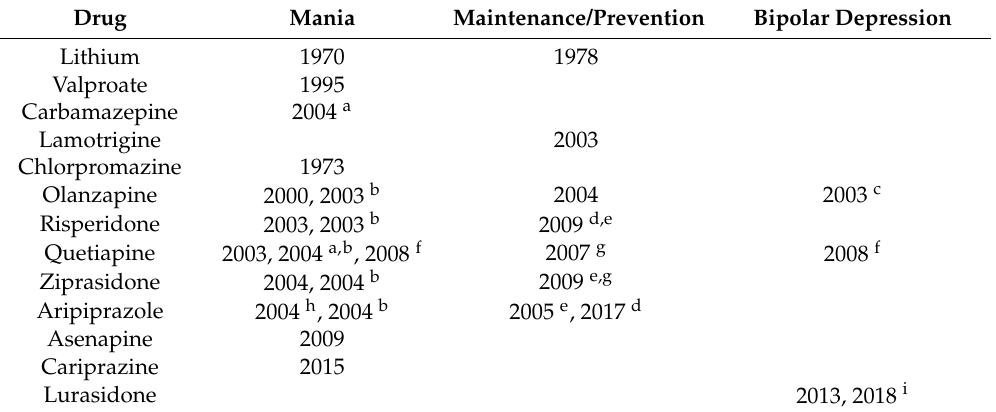
Table 2. Drugs approved by the Food and Drug Administration of the United States (USA FDA) for treatment of patients with bipolar